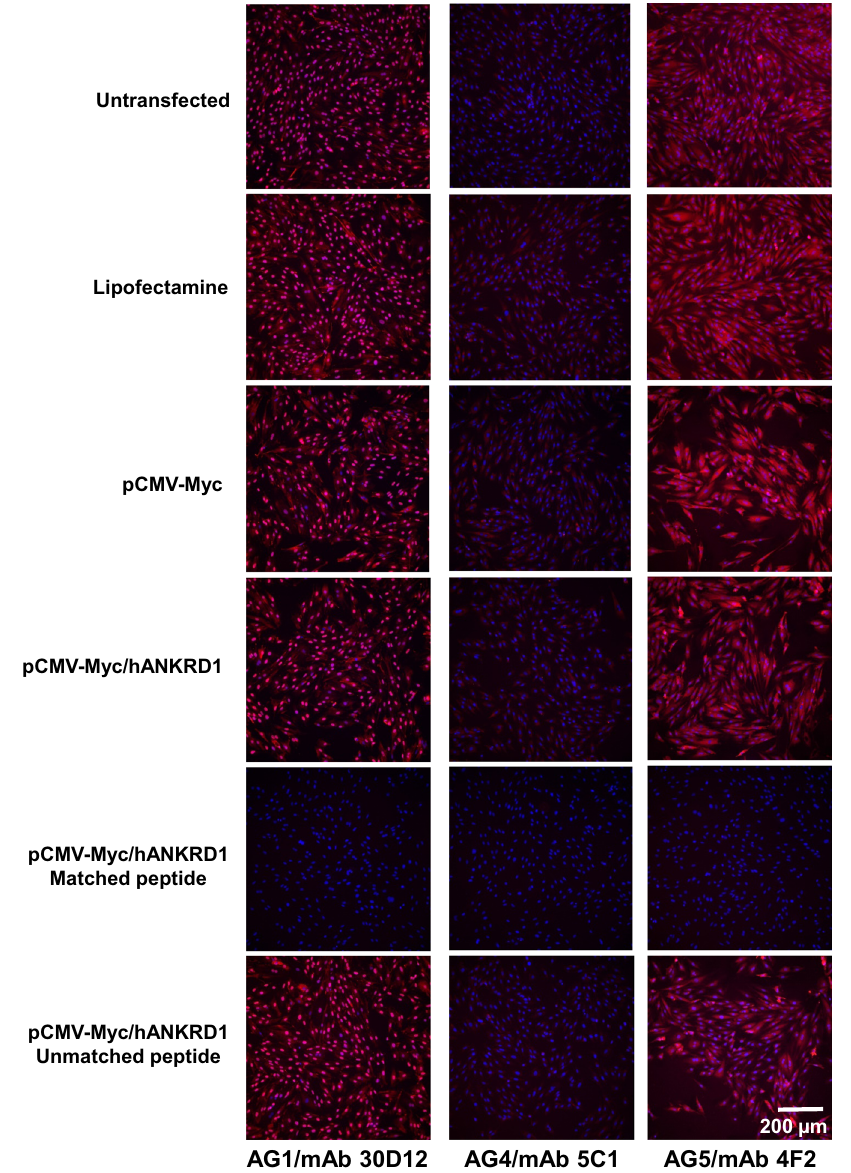
Fig. 6 Immuno fl uorescence staining of H9c2 cells under different treatment conditions. Panels represent merged images of cells stained for ANKRD1 (red) and nucleus (DAPI, blue). The antibodies used are indicated below the bottom panels. Blocking with the corresponding matched peptide of each mAb completely abolished staining for ANKRD1 in pCMV-Myc/hANKRD1-transfected cells. In contrast, blocking with the unmatched peptide for AG1/mAb 30D12 (AG4 peptide), AG4/mAb 5C1 (AG1 peptide) and AG5/mAb/ 4F2 (AG1 peptide) resulted in marginal loss of ANKRD1